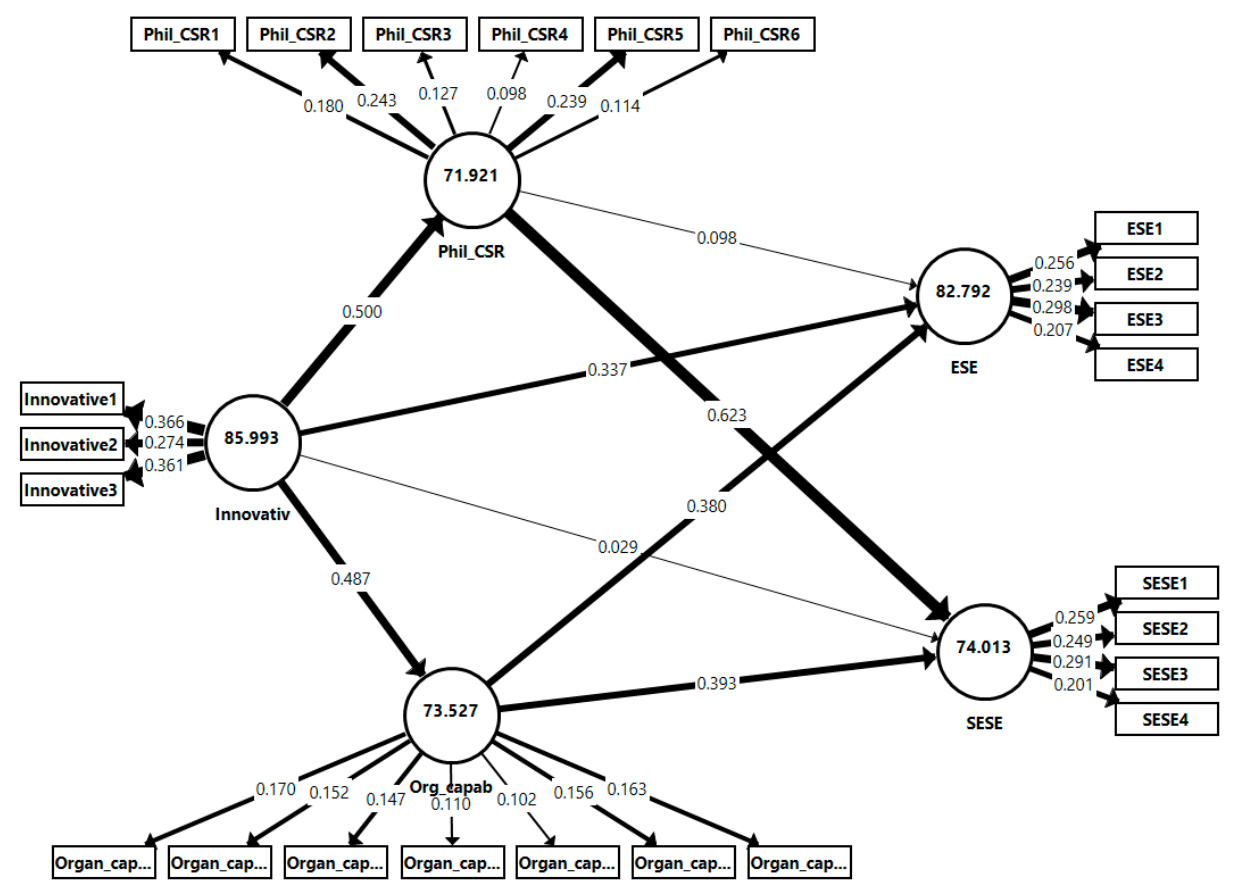
Figure 3. IPMA Model.